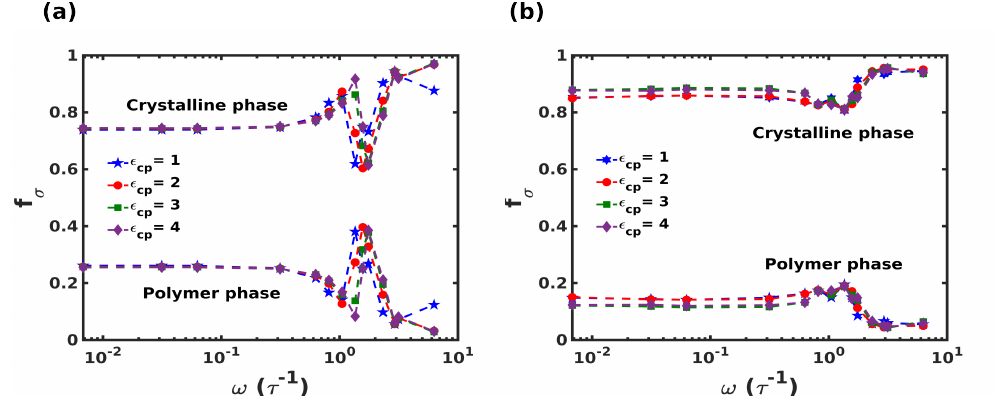
Figure 10. Stress fraction ( f σ ) of crystalline and polymer domain for ( a ) columnar composite and ( b ) staggered composite varying polymer-crystal interactions,